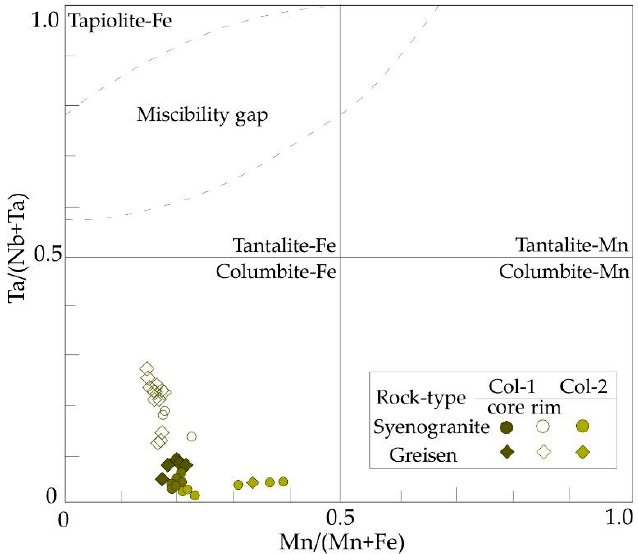
Figure 6. Columbite-group classification diagram with the Fe–Mn and Nb–Ta compositional variations for the columbite-crystals from the Desemborque Pluton.